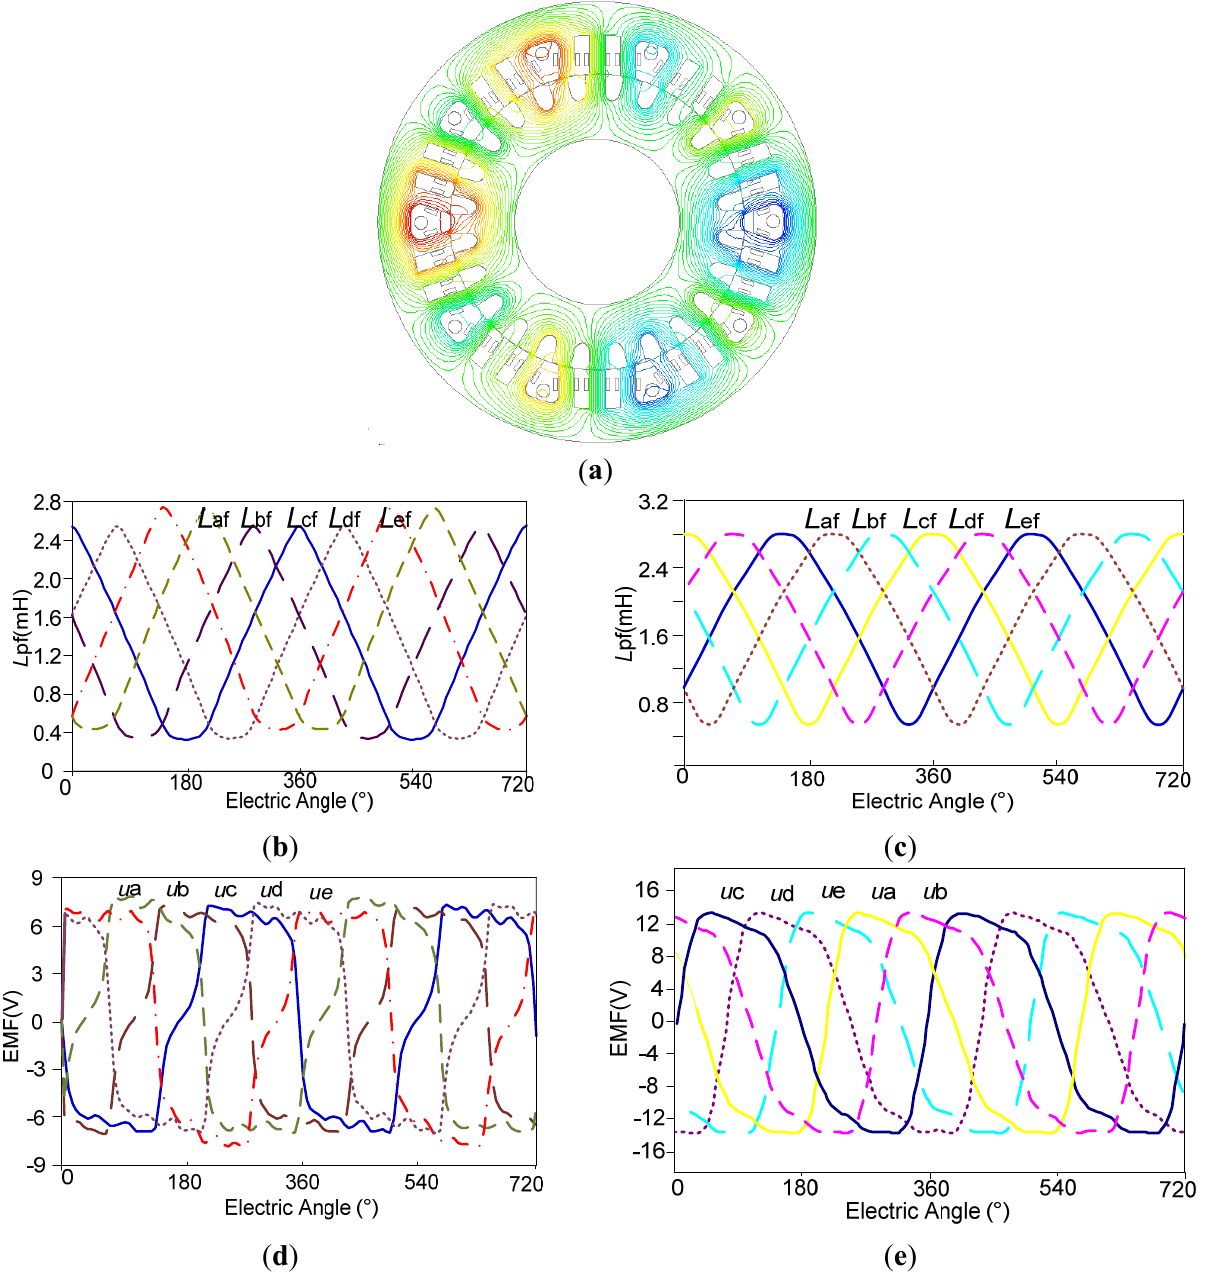
Figure 8. Comparison of the traditional and the new five-phase WFDSM. ( a ) The flux of the 30/24-pole WFDSM; ( b ) L pf of the traditional 10/8-pole WFDSM; ( c ) L pf of the new 30/24-pole WFDSM; ( d ) Back EMF of the 10/8-pole WFDSM; ( e ) Back EMF of the 30/24-pole